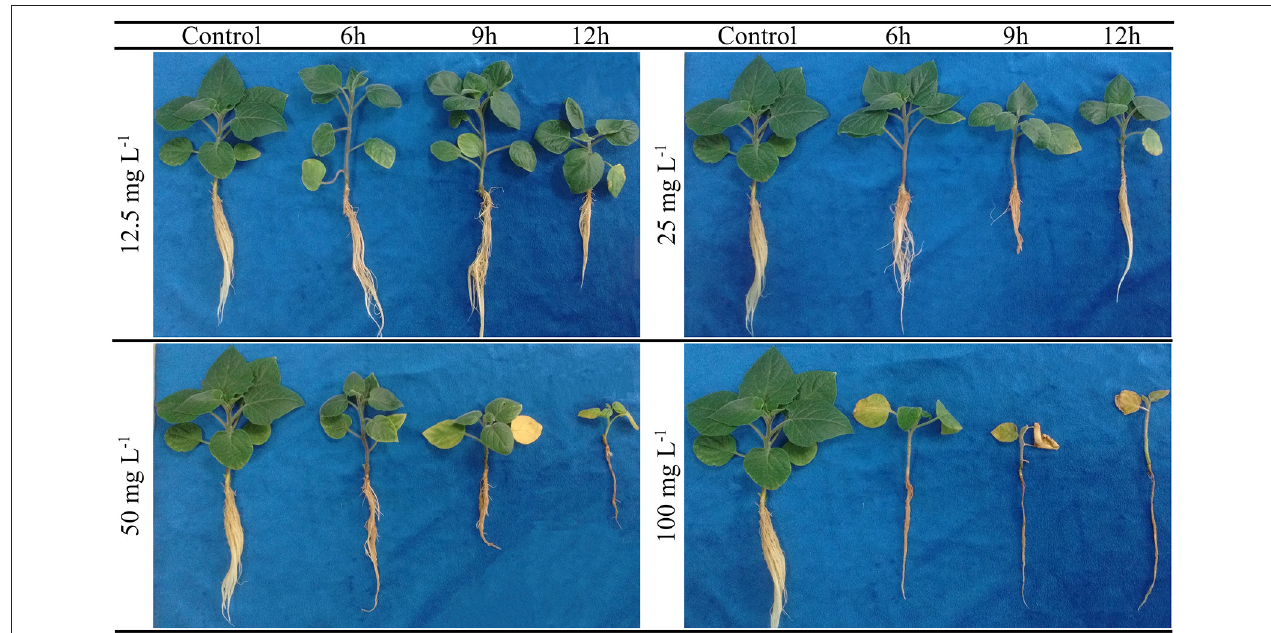
FIGURE 3 | Effect of four concentrations (12.5, 25, 50, and 100mg L − 1 ) of fusaric acid and three exposure periods (6, 9, and 12h) on the development of symptoms of cape gooseberry plant ecotype Colombia in a hydroponic system 9 days after